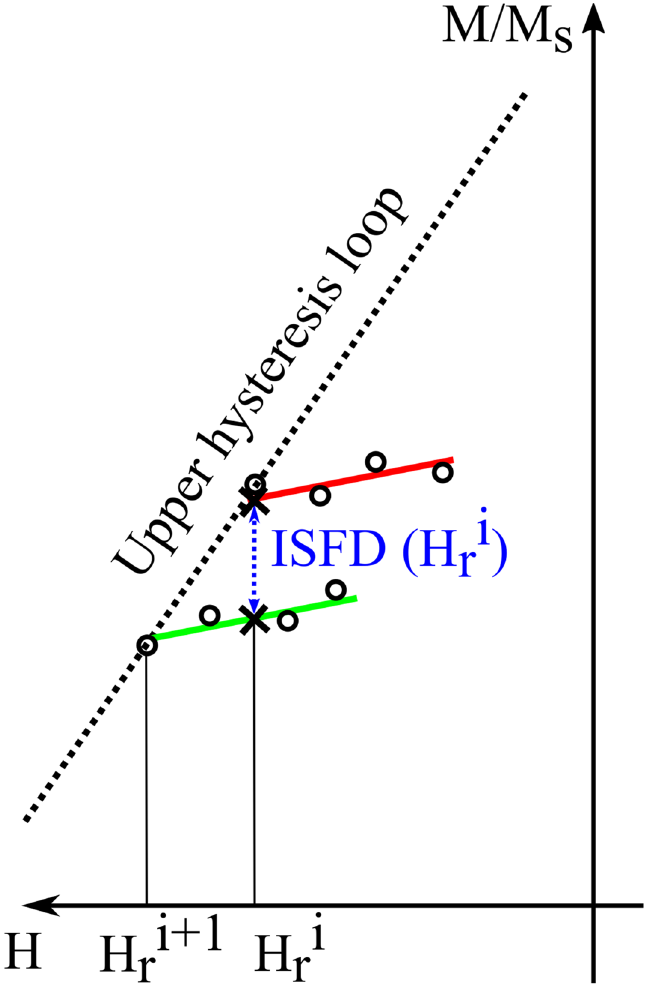
Figure 7. Calculation of smoothed ISFD: The upper (red) FORC begins at H r i and has four measured points (black dots). A straight red line is least-squares fit to these points. The lower FORC begins at H r i+1 and its points are similarly fit to the green line. The black Xs are the points on the two lines with H = H r i , and the vertical distance between them is proportional to the